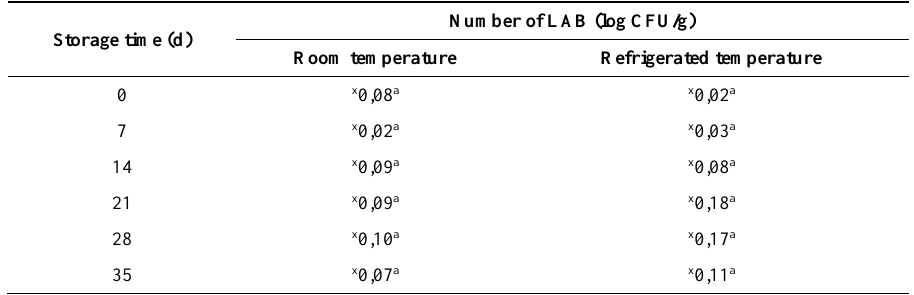
Table 6. The amount of reduction in strain B1295 microencapsulated with CMFH from OPT at different temperatures for 35 days storage and treated with pH 2 Storage time